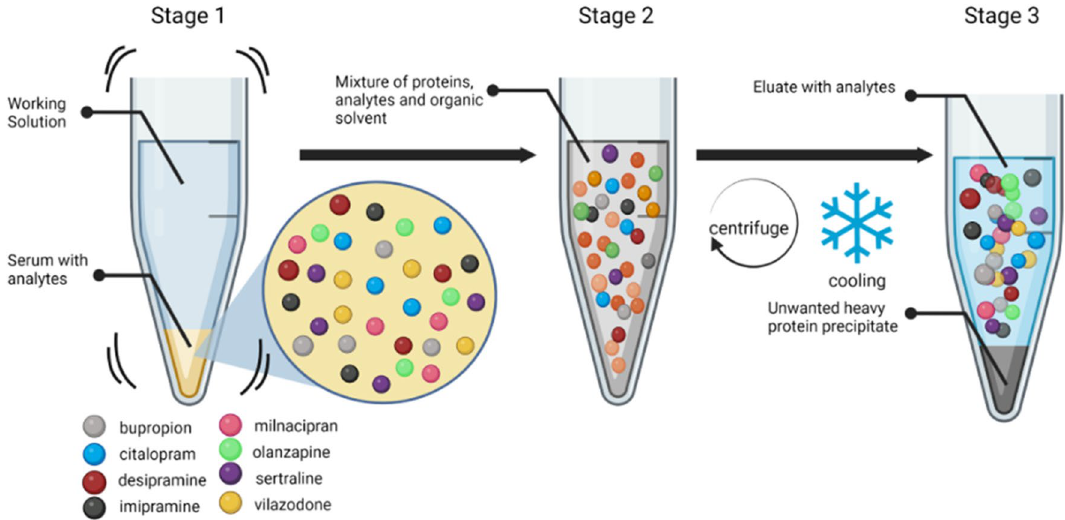
Figure 1. An illustration of the antidepressant molecular motion as observed in our sample preparation